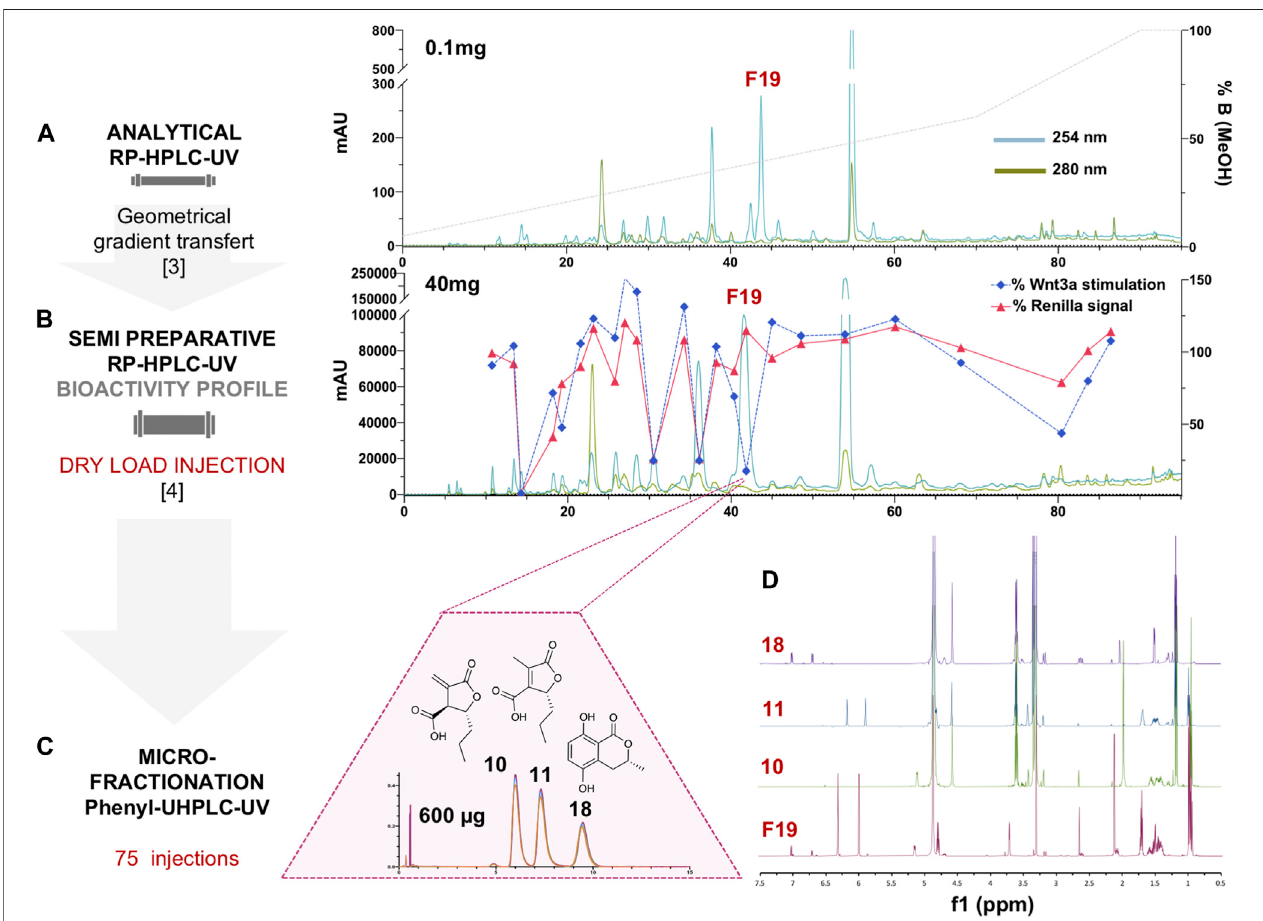
FIGURE 1 | (A) Analytical HPLC-PDA pro fi le of the enriched hydroalcoholic fraction of L. venezuelensis extract (A02EtM). (B) Semi-preparative HPLC-UV pro fi le of the fraction A02EtM with an overlay of the Wnt inhibition bioactivity pro fi le of fractions collected by semi-preparative fractionation. Bioactivity values of each fraction at 33 μ g/ml are expressed as a response to Wnt3a stimulation in % of control and response of Renilla luciferase in % of control (cytotoxicity). The fraction named F19 was the only one to show speci fi c anti-Wnt activity, while other fractions were cytotoxic and the decrease of Wnt signal was due to this effect. (C) UHPLC-UV microfractionation of F19 repeated 75 times on a phenyl column for enhanced chromatographic selectivity. (D) Comparison of the 1 H-NMR spectra of F19 and the isolated compounds 10, 11, and 18.